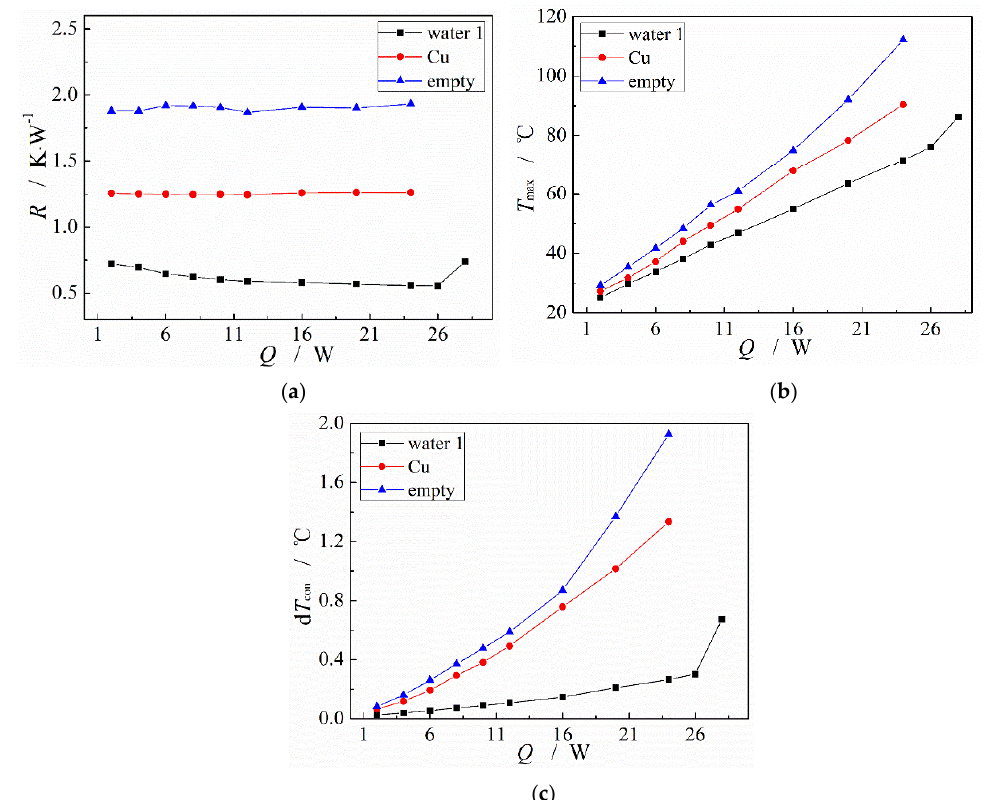
Figure 9. Comparison of the heat transfer performance between the MGFHP and copper plate: ( a ) thermal resistance; ( b ) maximum temperature at evaporation section; and ( c ) temperature nonuni- formity at condensation section.